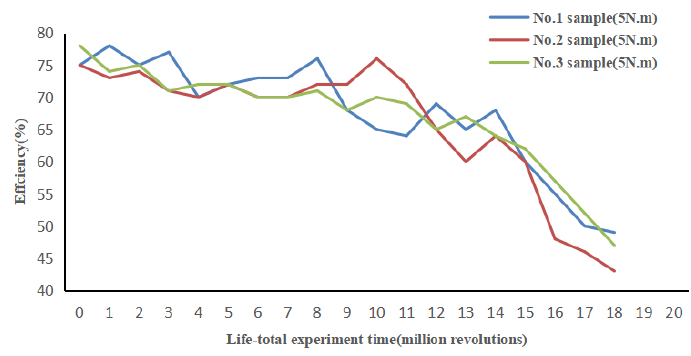
Figure 7. Efficiency test curve at torque 5 N.m.